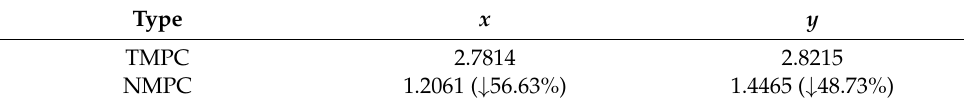
Table 6. The RMSE comparisons of the tracking errors of x and y under the